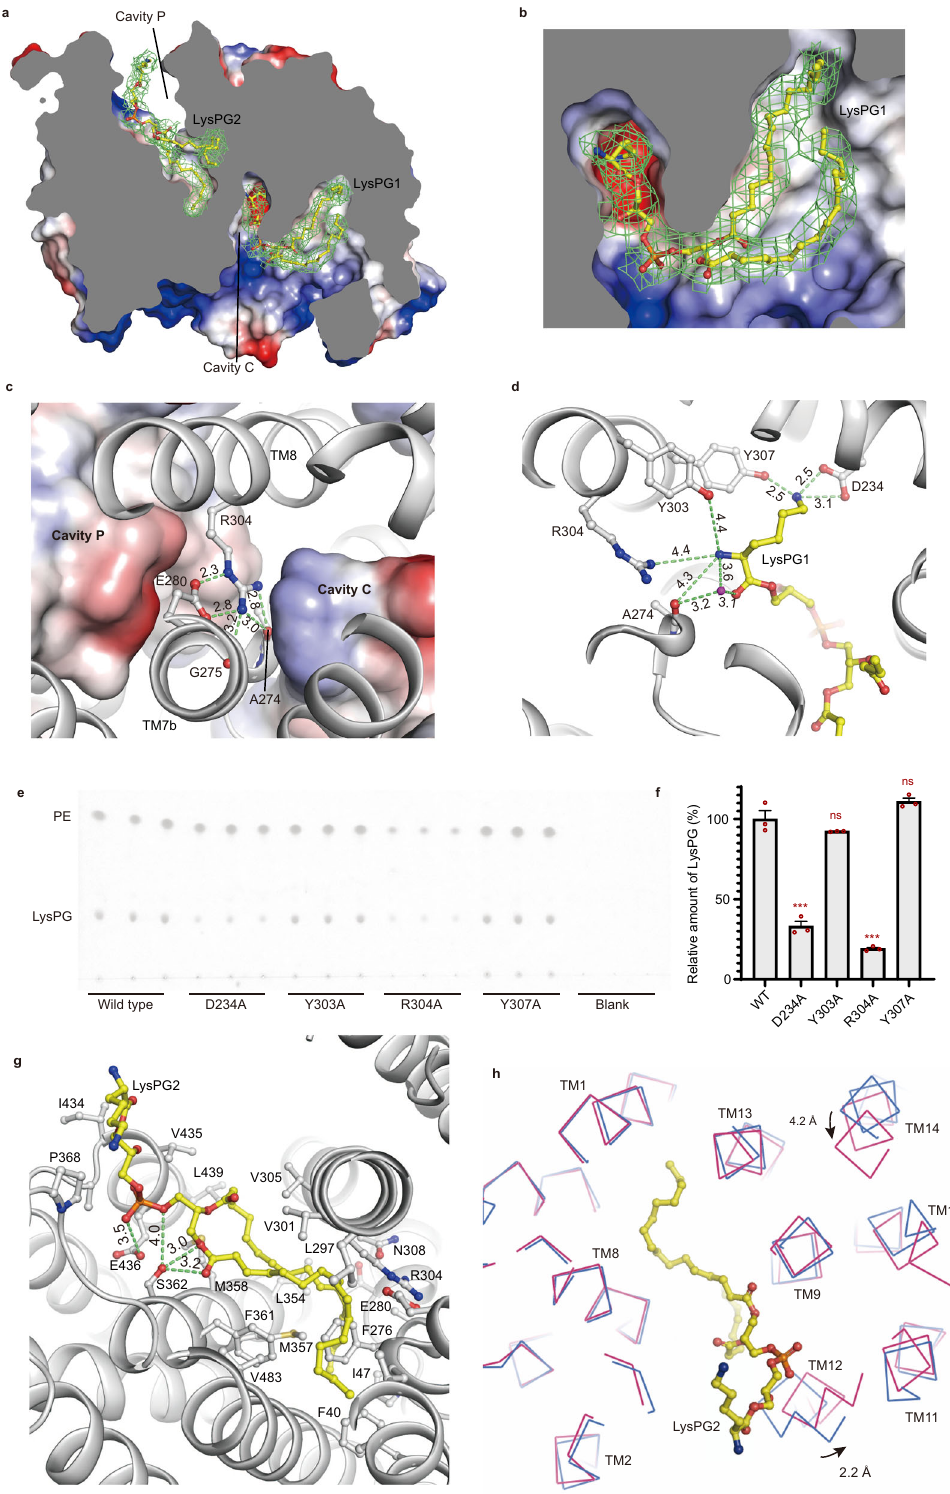
periplasmic surface and belong to a phospholipid molecule tentatively assigned as LysPG2 in the model. The third acyl chain is much shorter than the other two, likely belonging to a detergent molecule. While the density for the two fatty-acyl chains of the phospholipid molecule are fairly strong and clear, the head-group density is relatively weak. When the map contour level is lowered, the density corresponding to the lysyl group becomes visible and